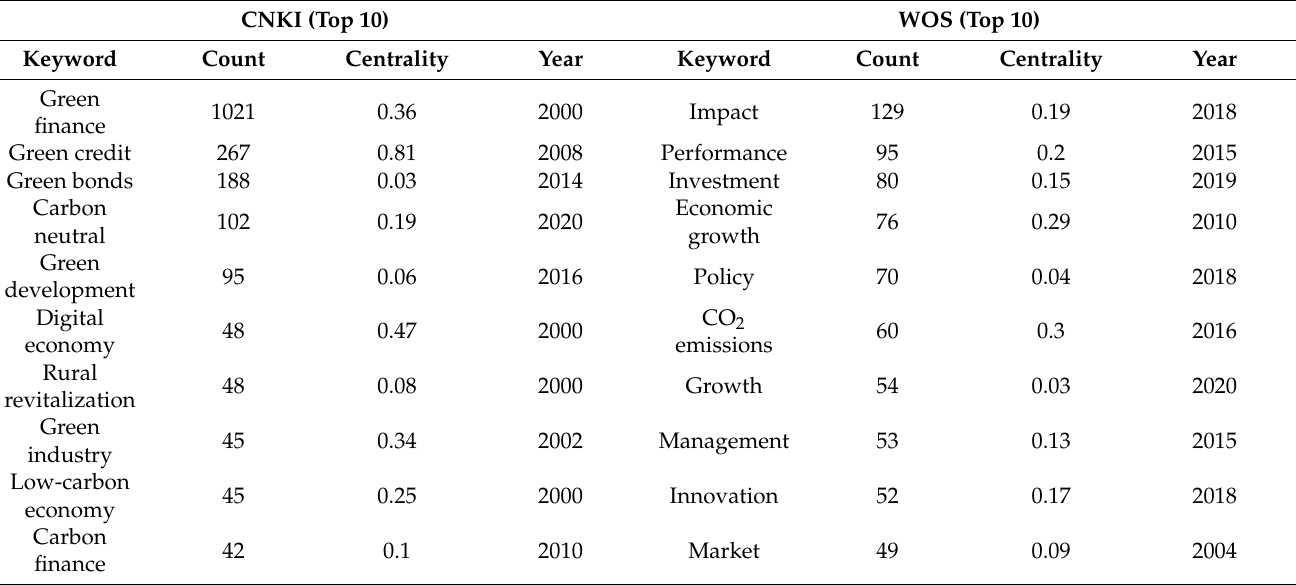
Table 4. Keyword frequency comparison